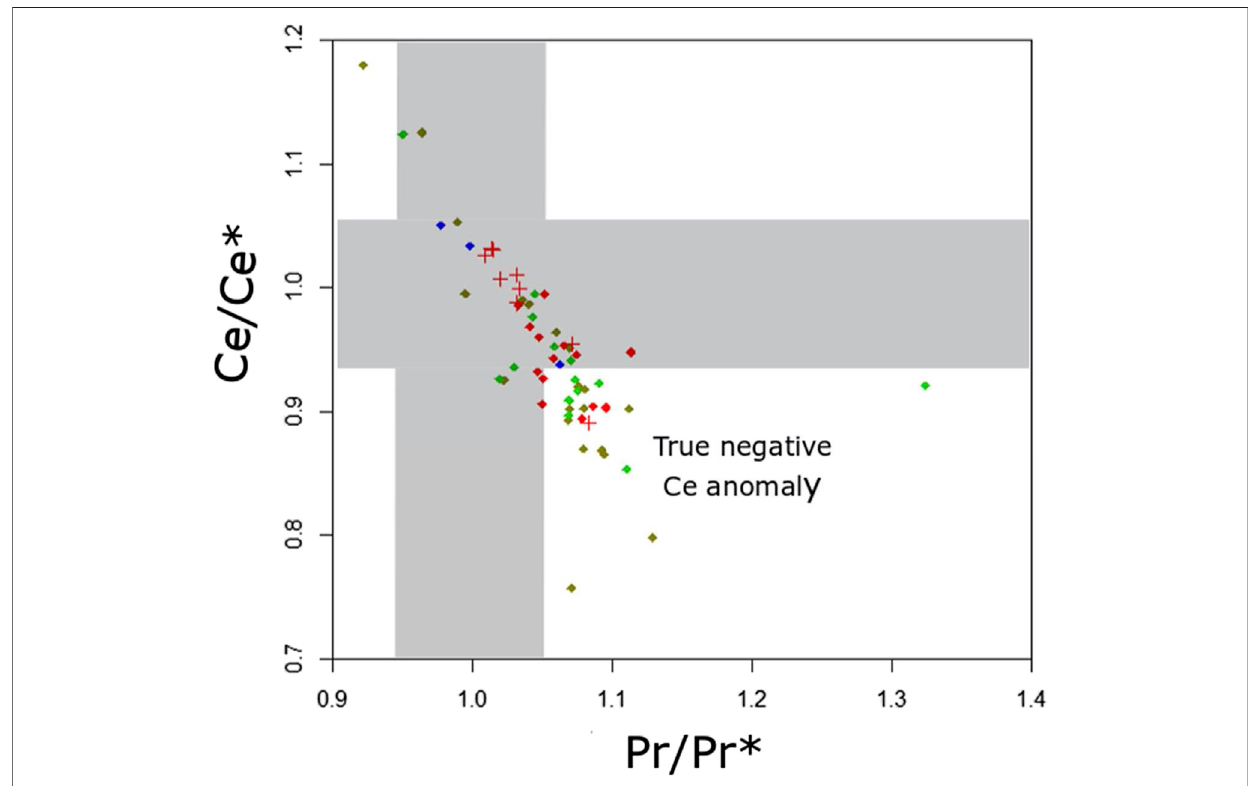
FIGURE8| PlotofCeandPranomalies.Greyareasindicatenotrueanomaly(BauandDulski,1994;Planavskyetal.,2010).Coloursre fl ectfacies:blue (cid:1) clastic rich F1 and F3, green (cid:1) F5, brown (cid:1) F6, red (cid:1) F7, red crosses (cid:1) F7 from drill core. ‘ True ’ Ce anomalies are de fi ned by Ce versus Pr values above and below unity, discriminating between positive La and true negative Ce anomalies as described by Bau and Dulski (1994).